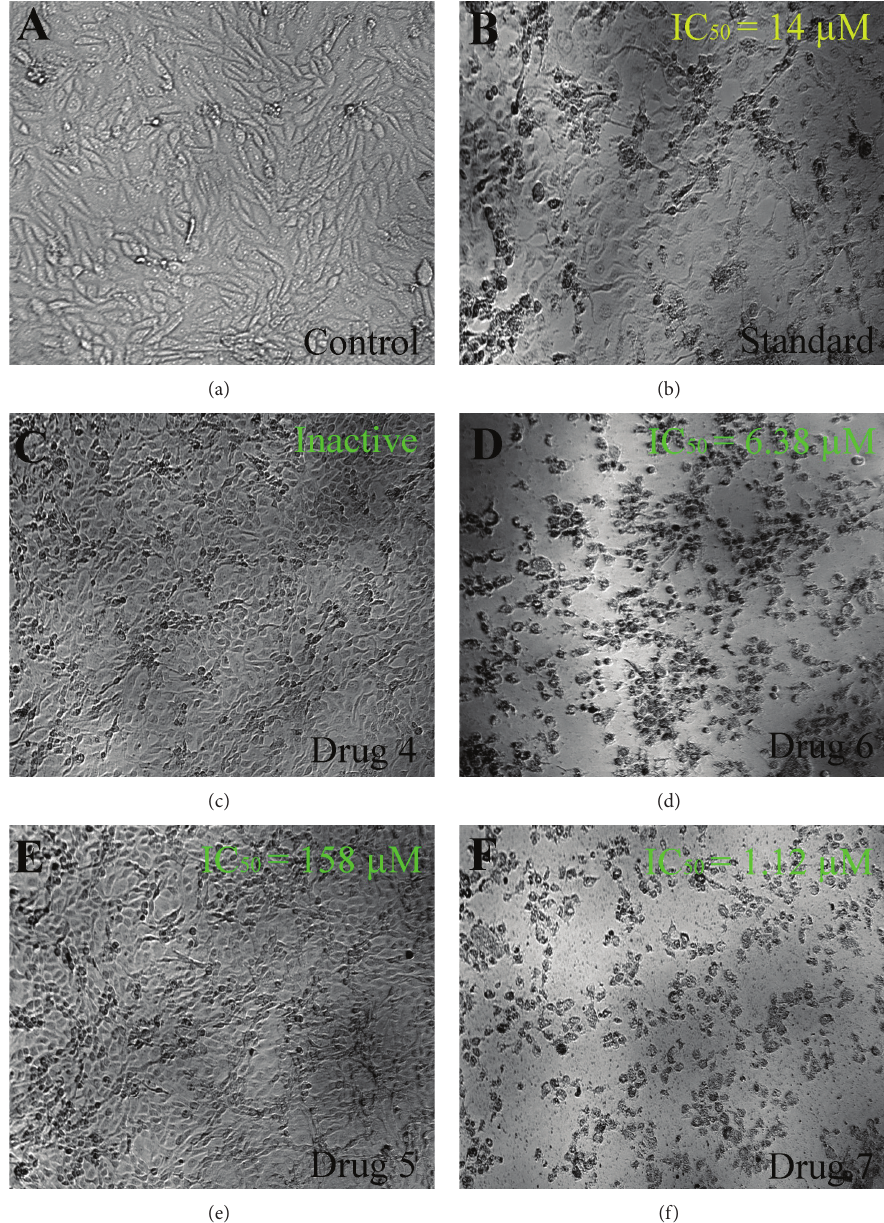
Figure 7: Human hormone estrogen dependent ductal breast carcinoma cell line MCF 7 cell images were taken under an inverted phase- contrast microscope at × 200 magnification with a digital camera at 48hours after treatment with the samples. (a) Photomicrograph depicts the MCF 7 cells from the control group formed a compact confluent layer, where all the cells displayed aggressive multiplication and intact cellular membrane. In treatment groups, generally, the complexes demonstrated more significant activity than their respective ligands. (b) Treatment with tamoxifen showed marked inhibition in cell proliferation with IC 50 = 14 𝜇 M. The picture revealed that the population of the cells is reduced drastically. (c) The treatment with 4 showed moderate to least cytotoxicity, with higher IC 50 value is found to be > 200 𝜇 M. (d) Treatment of MCF 7 cells with 6 showed strong cytotoxic effect (IC 50 = 6.38 𝜇 M) as the antiproliferative effect was similar to that of the standard reference tamoxifen. The viability of the cells was severely affected, as the photomicrograph showed all the treated cells lost their viable characteristic features. (e) Treatment with 5 showed mild antiproliferative activity on MCF-7 cells. The IC 50 was determined to be 158 𝜇 M. (f) Photomicrograph of MCF-7 cell treated with 7 showed potent inhibition in cell proliferation with IC 50 = 1.12 𝜇 M. The picture revealed the strong cytotoxic activity of the complex as the cells undergo apoptotic changes with the clear evidence of membrane blebbing and nuclear